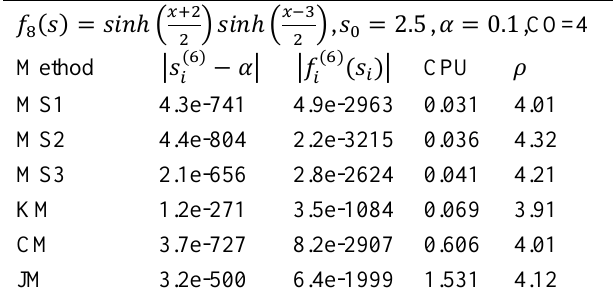
Comparison of single roots finding